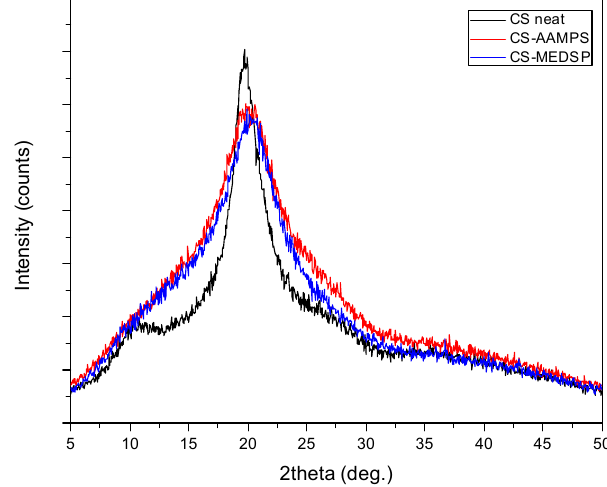
Figure 2. XRD patterns of neat CS and its derivatives with AAMPS and MEDSP.